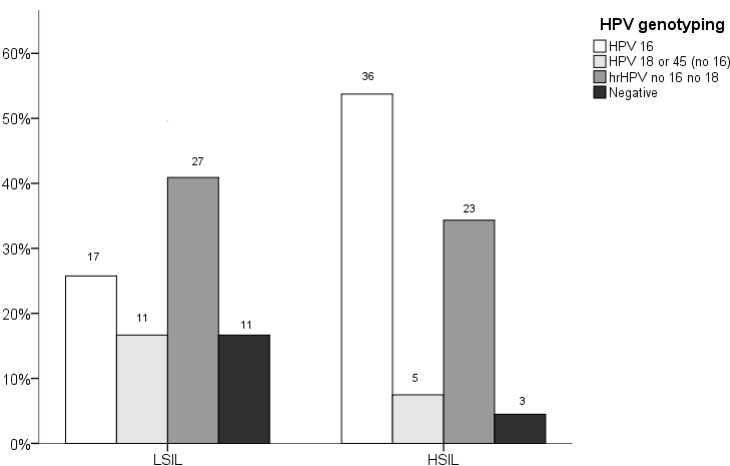
Figure 3. Human papillomavirus (HPV) genotyping in the patients with anal lesions. The criteria for the group of low-grade squamous intraepithelial lesion (LSIL) were: Pap test result of LSIL and biopsy showing anal intraepithelial neoplasia grade 1 [LSIL/AIN1]); the criteria for high-grade squamous intraepithelial lesion (HSIL) were: Pap test result of HSIL and biopsy confirming HSIL/AIN2–3). The results are presented in absolute numbers. Bars represent the percentage of HPV genotypes within the diagnostic group.